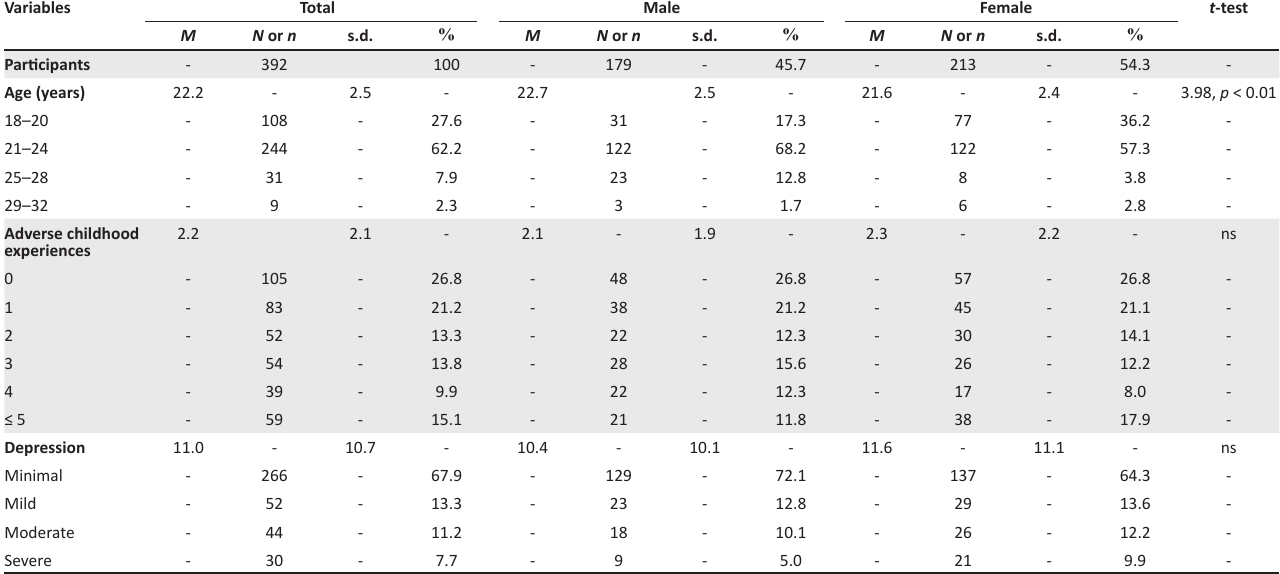
TABLE 1: Socio-demographic characteristics and prevalence of adverse childhood experiences and depressive symptoms in the study participants.